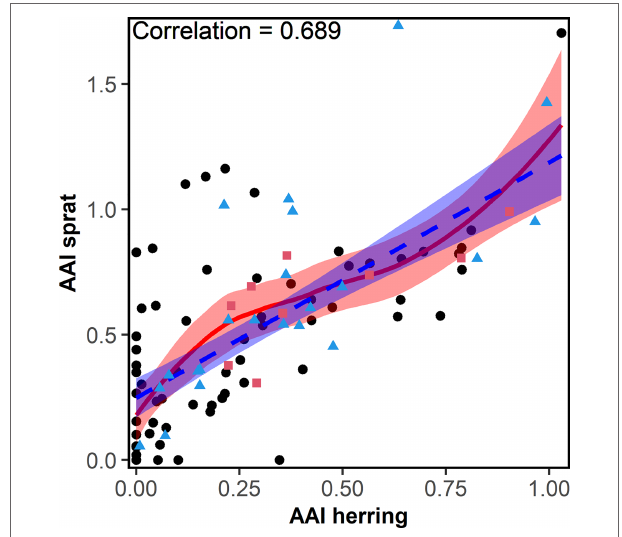
FIGURE 4 | Correlation (including the correlation factor) between the herring and sprat annual abundance index (AAI) collected from 1919-2018 during the annual beach seine survey along the Norwegian Skagerrak coast. Red points (squares) were used for the sprat model, blue points (triangles) were used for both, sprat and herring, models. The fitted linear (dashed-blue) and locally weighted smoothing (loess) line (solid-red) and their 95% confidence intervals are